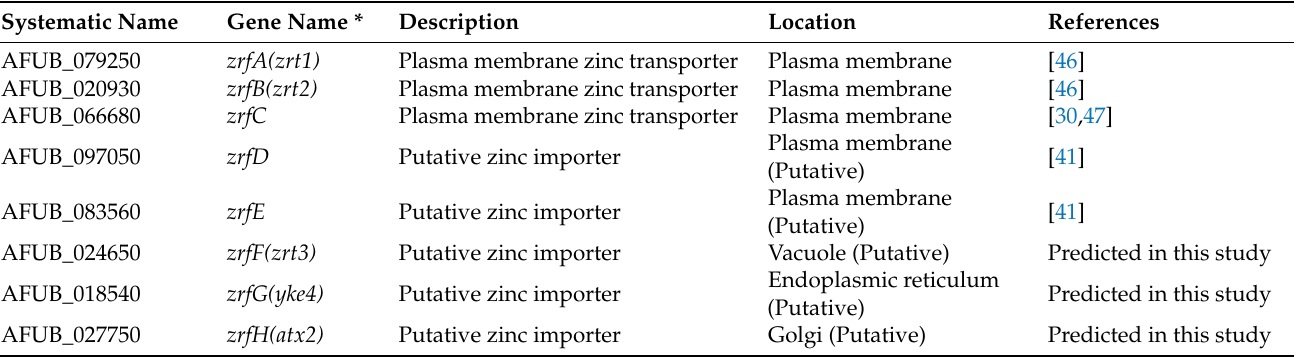
Table 1. Zinc homeostasis-related genes of Aspergillus fumigatus ZIP protein